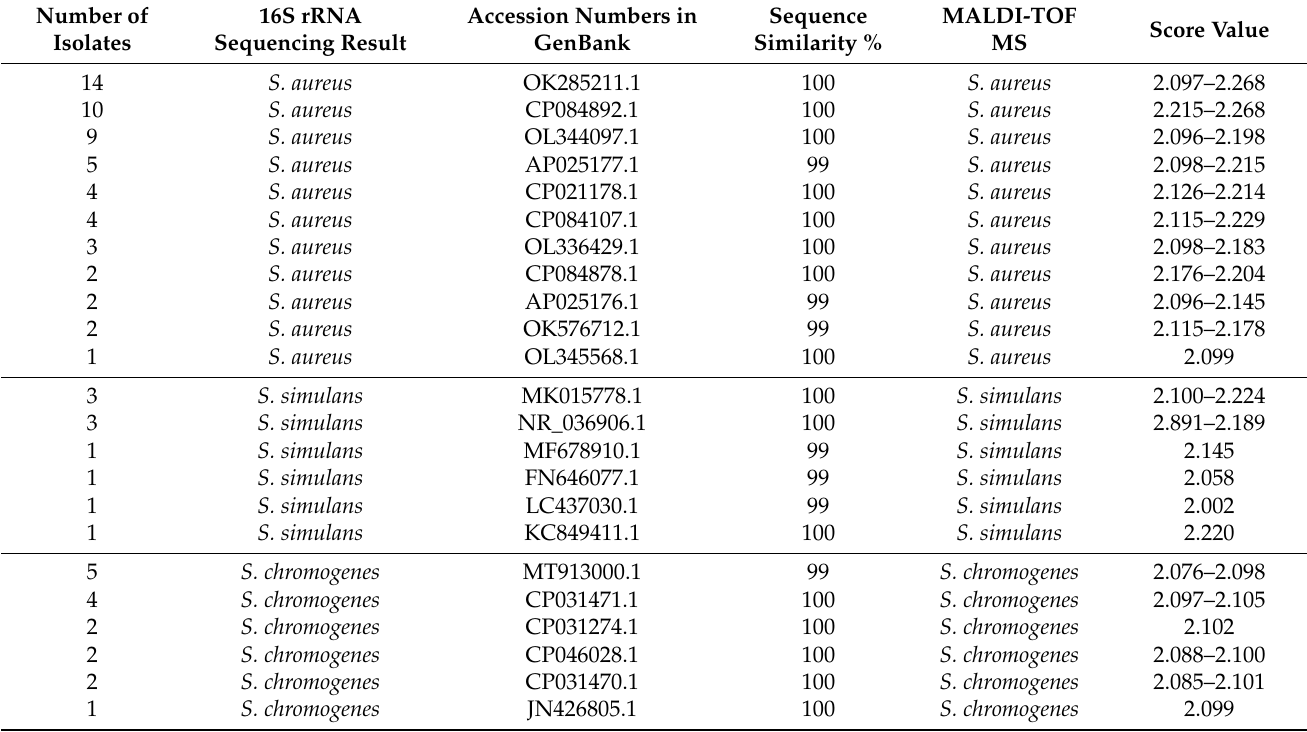
Table 2. Identification of 82 Staphylococcus isolates from cheese through 16S rRNA sequencing and MALDI-TOF MS.